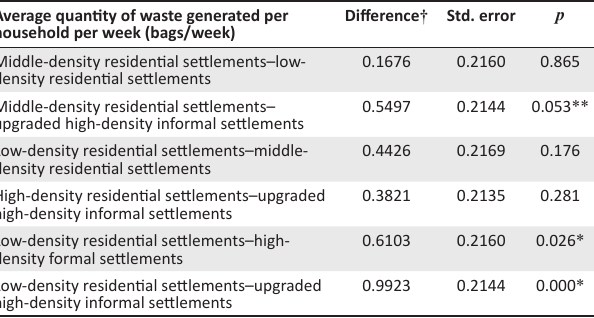
TABLE 5: Summary of statistics comparing the quantity of solid waste generated per household per residential settlement in Mthatha, South Africa ( N = 248). Average quantity of waste generated per Difference † Std. error p household per week (bags/week)